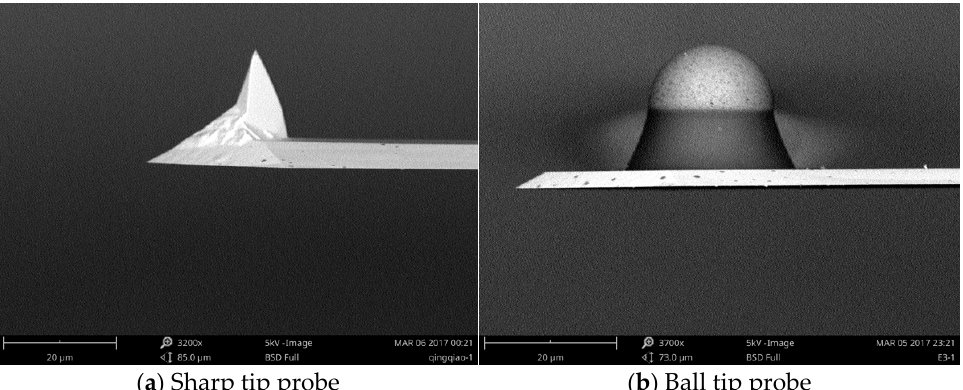
Figure 4. SEM images of probe tips: ( a ) sharp tip and ( b ) ball